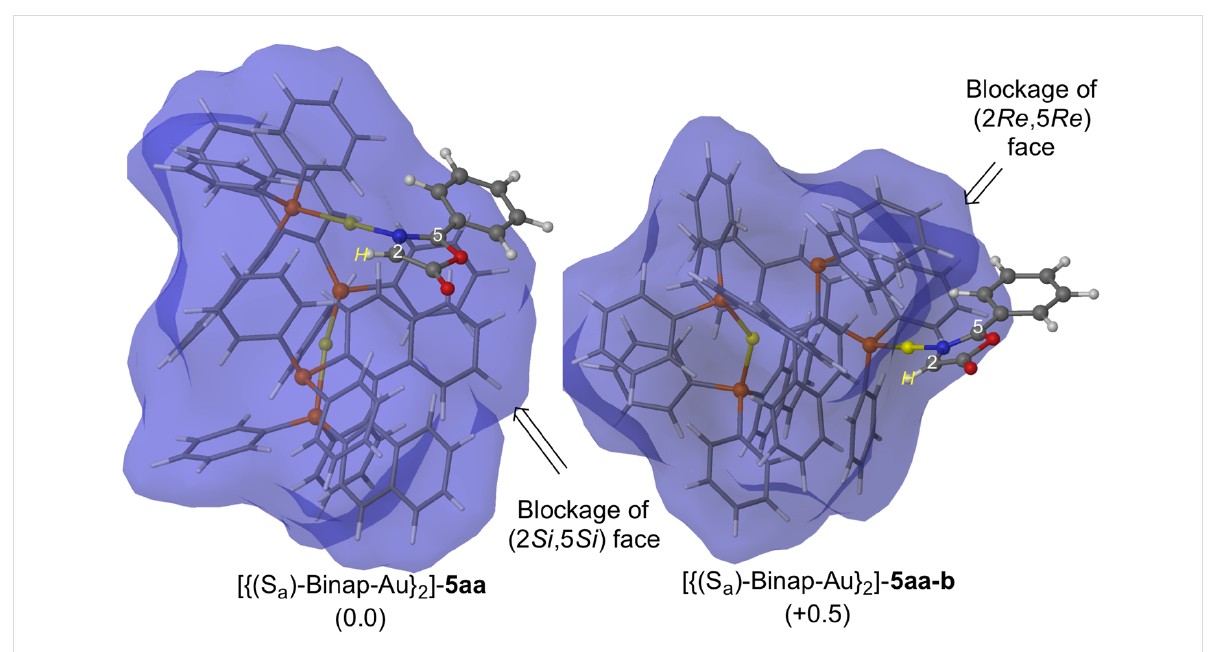
Figure 3: Main geometrical features and relative Gibbs free energies (in kcal mol − 1 at 298 K) of complexes [( S a )-Binap-Au] 2 - 5aa and [( S a )-Binap- Au] 2 - 5aa-b computed at M06/Lanl2dz//ONIOM (b3lyp/Lanl2dz:UFF). High-level and low-level layers are represented as ball and stick and wireframe models, respectively. Blue surface represents the solvent-accessible surface with a probe radius of 1.9 Å.